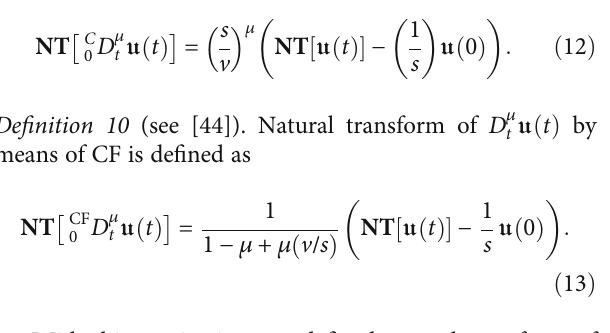
, and (c) absolute error of NTDM CF